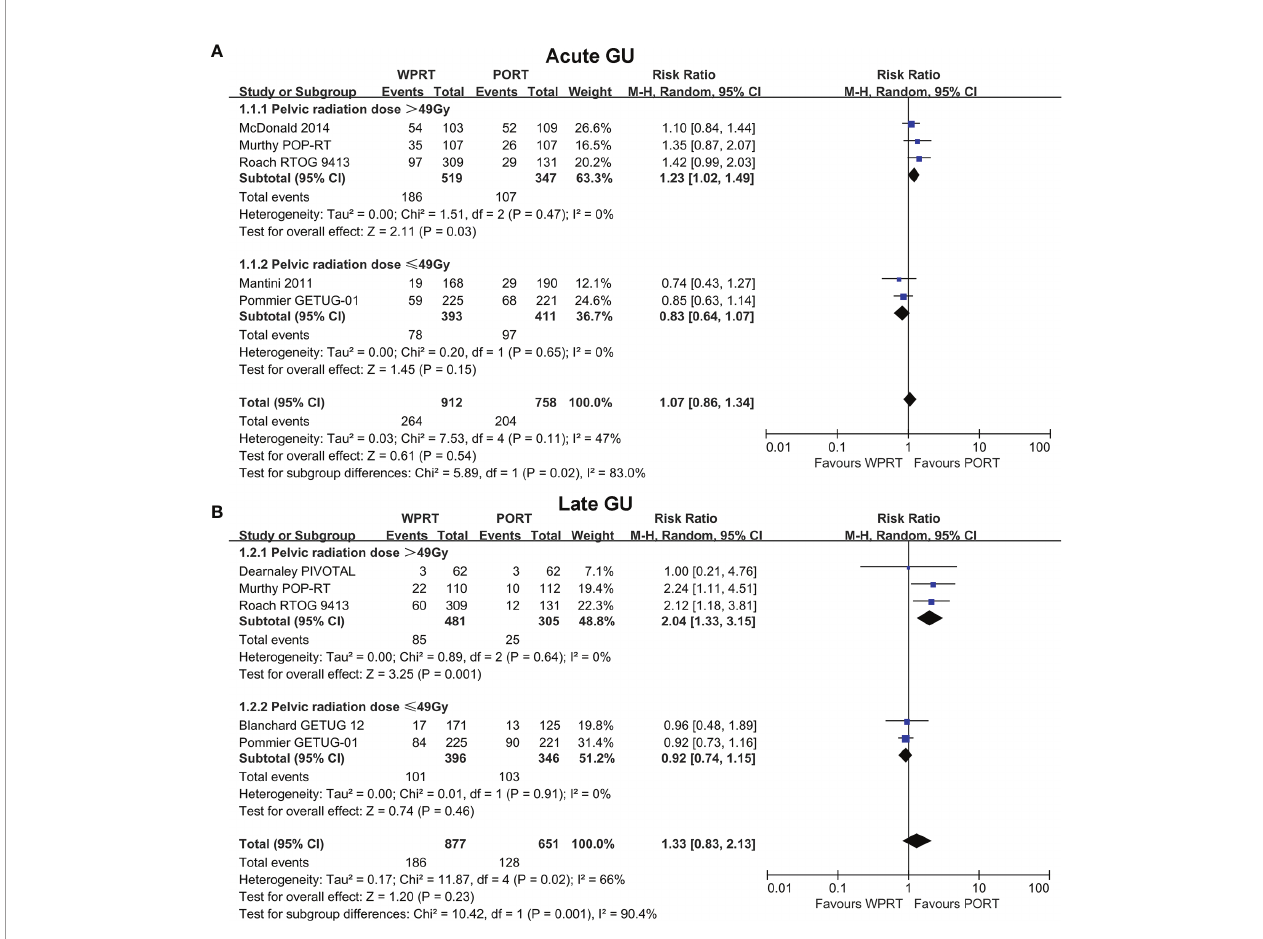
FIGURE 4 | Subgroup analysis of radiation dose for non-RP studies. Acute GU (A) and Late GU (B) of pelvic radiation dose. CI, con fi dence interval; WPRT, whole- pelvic radiotherapy; PORT, prostate-only radiotherapy; GU,